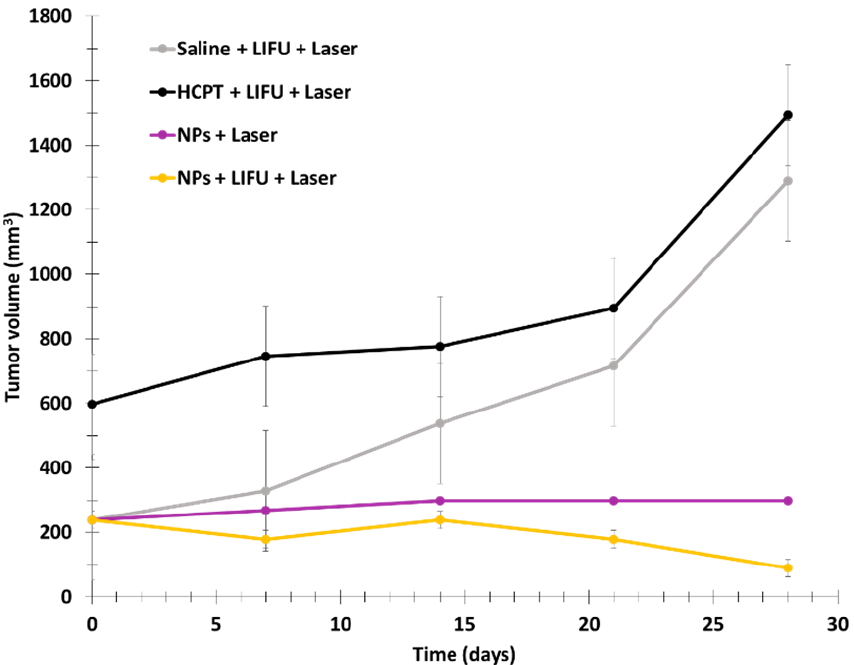
of 92.35% was observed for group 4, demonstrating a significant synergistic antitumoral effect (Figure 17).